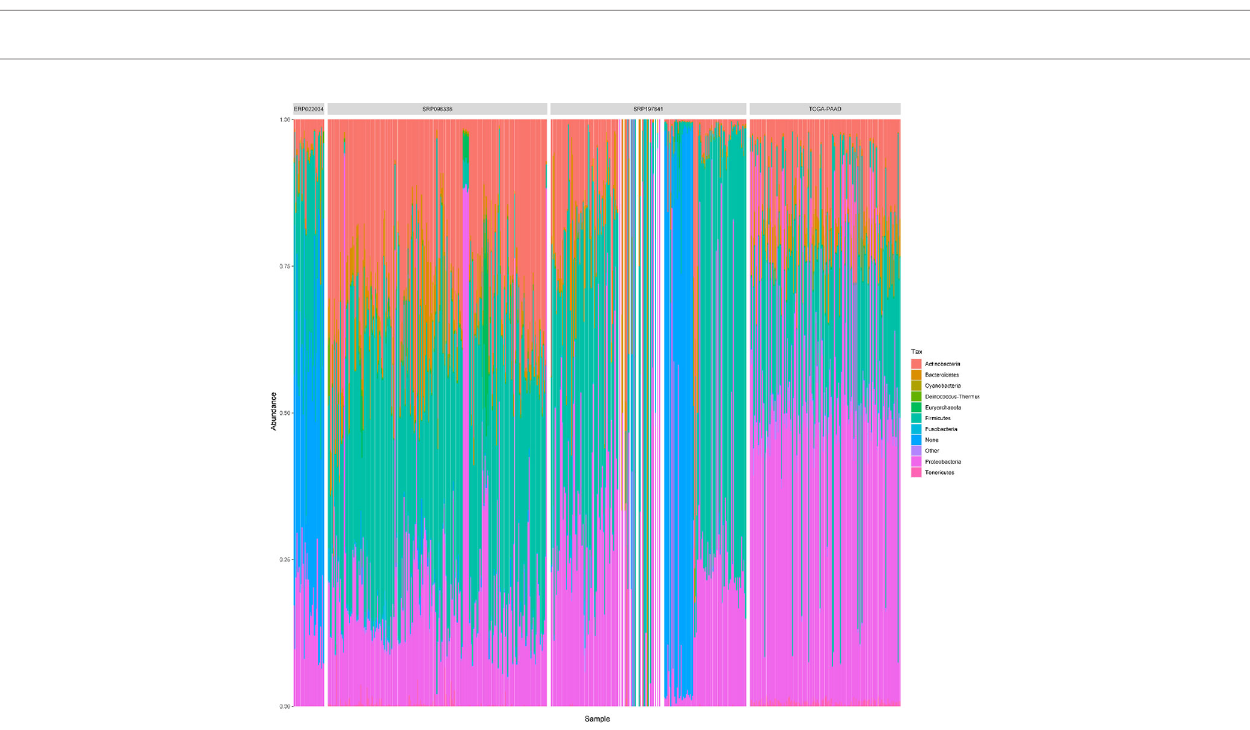
FIGURE 4 | The relative abundances of top 10 phylum in all samples across the 4 datasets. “ Other ” represents a collection of the taxa with lower relative abundances. ‘ None ’ represents the taxa that has no assignment at the phylum